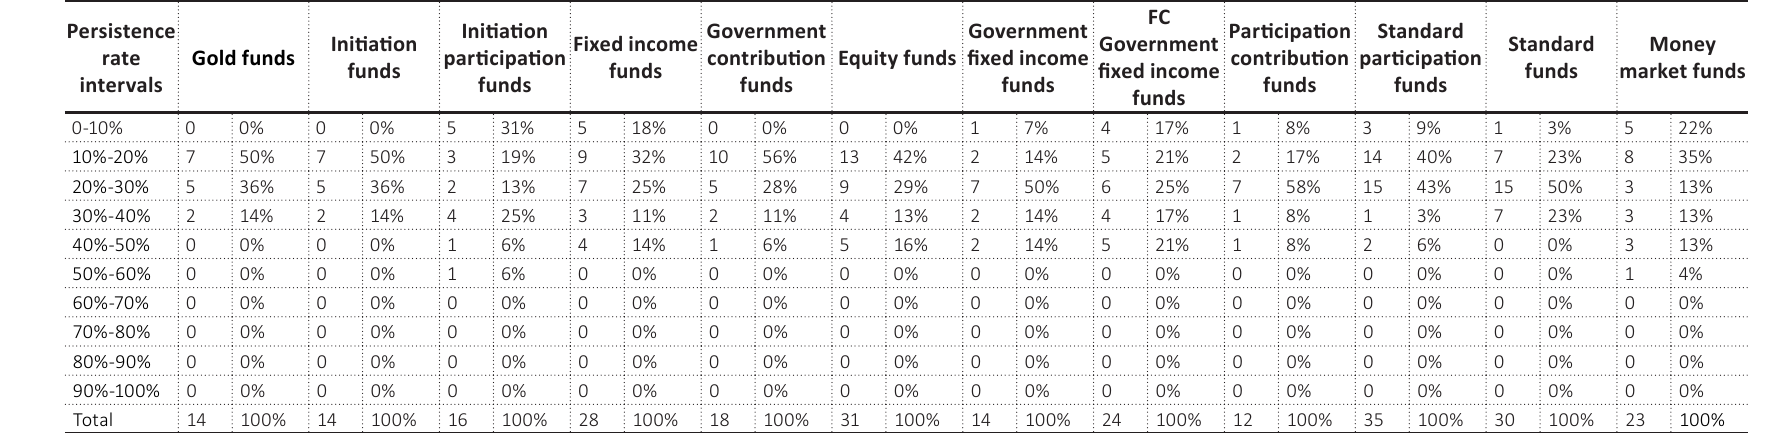
Source: Authors’ calculations.